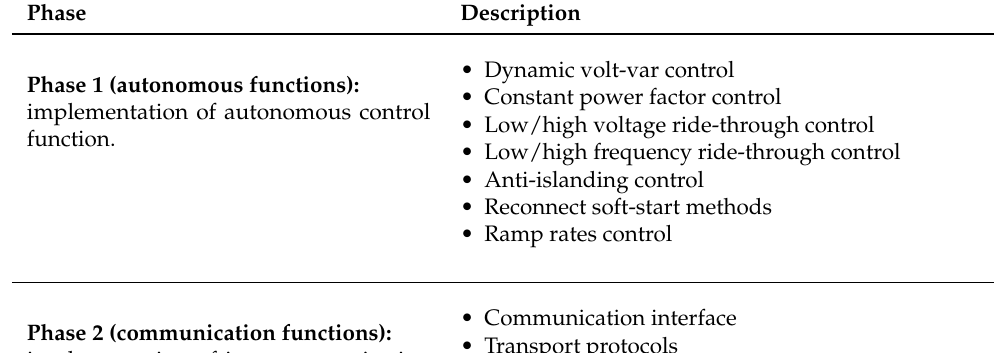
Table 1. Summary of functional requirements for